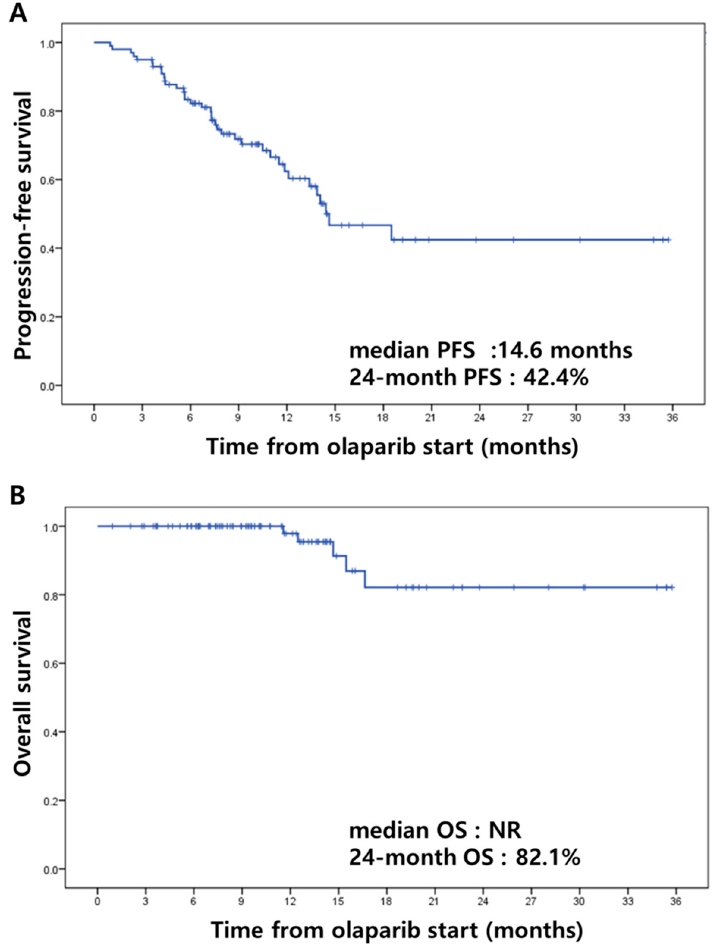
Figure 1. Kaplan–Meier estimates of progression-free survival ( A ) and overall survival ( B ). (NR: not reached).